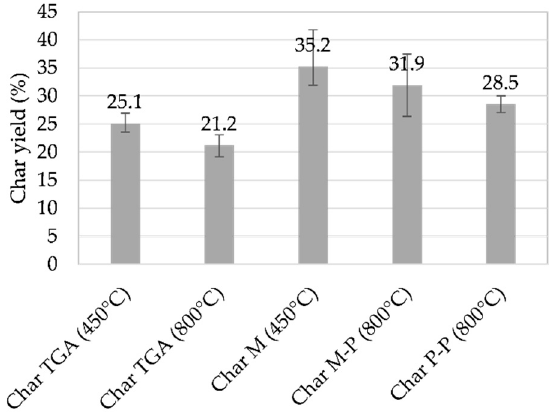
Figure 6. Char yield obtained in each char preparation condition (see Table 2).